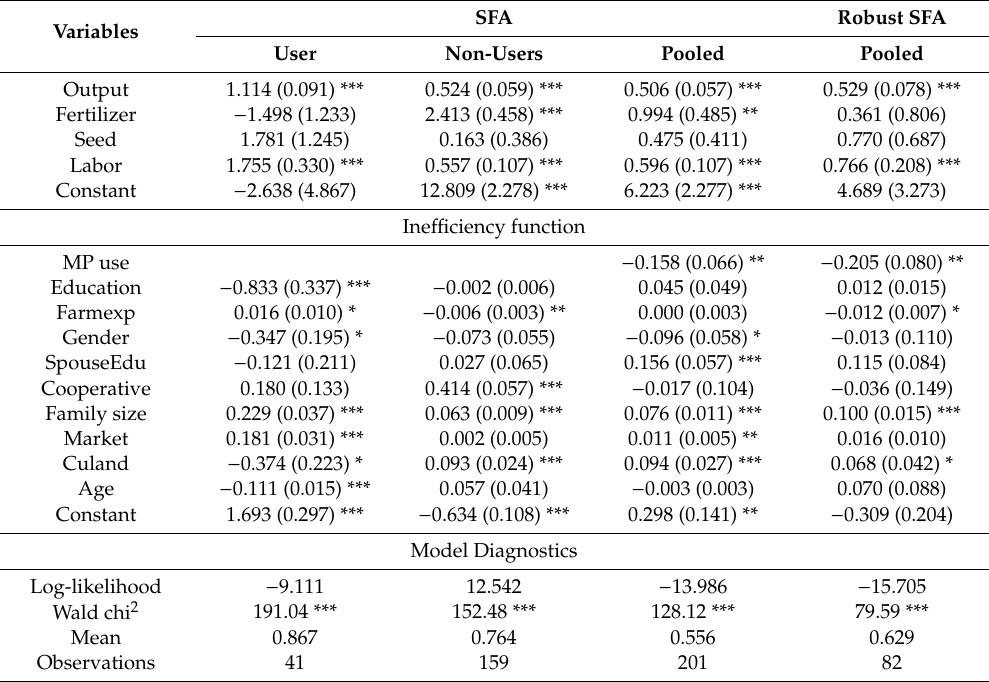
Table 2. SFA Maximum Likelihood